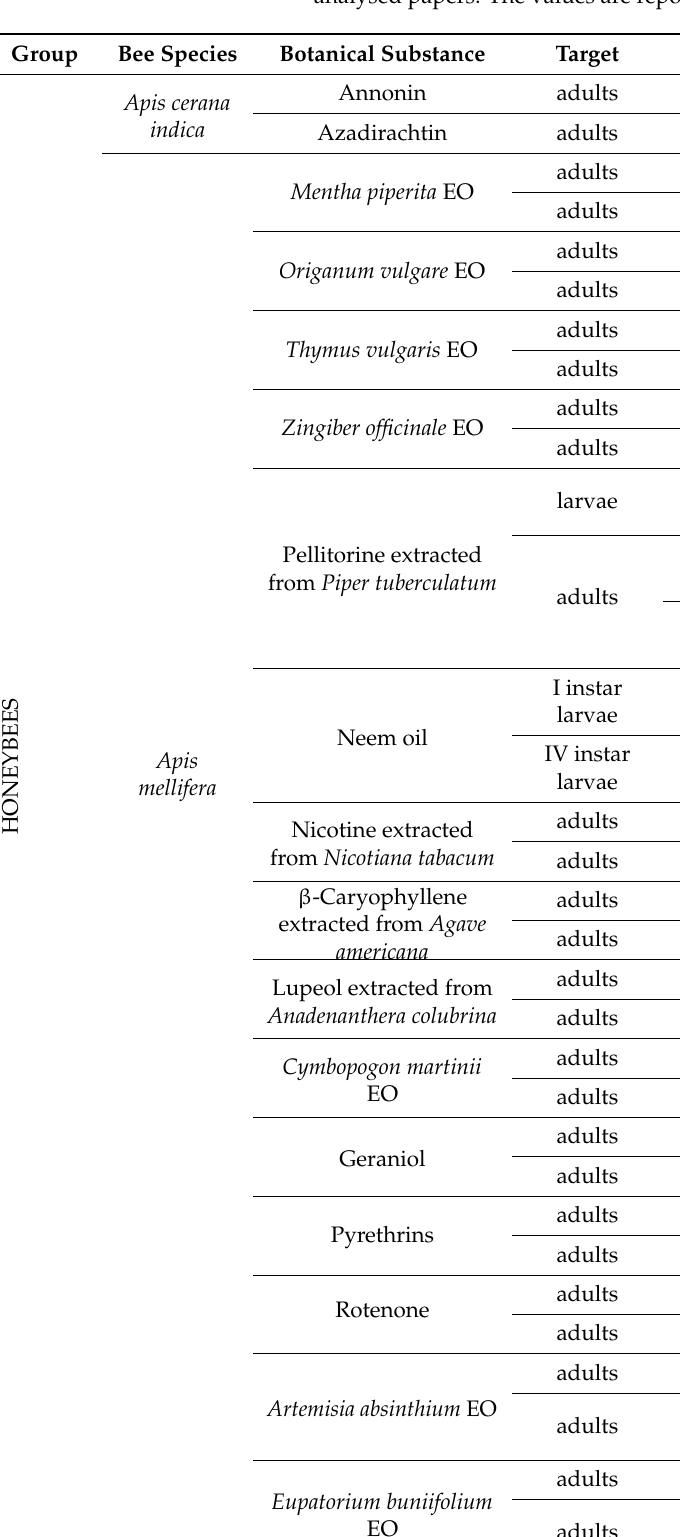
Table 2. Toxicological parameters (LC 50 , LD 50 ) of botanical biopesticides extrapolated from the analysed papers. The values are reported as they were reported in the